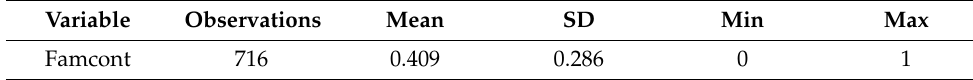
Table 4. Distribution of the proxy for family